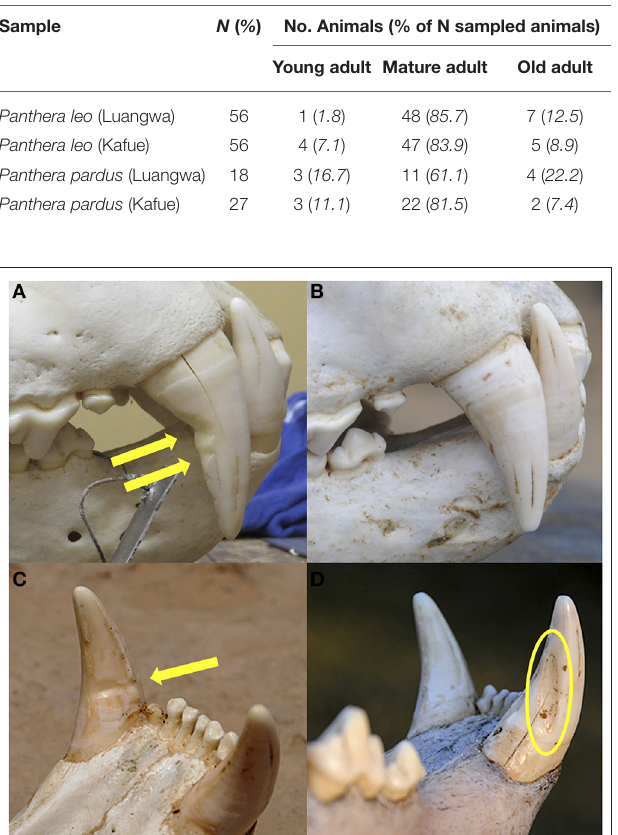
FIGURE 2 | Lion upper canine teeth of (A) a snared lion showing characteristic horizontal notches (arrows) resulting from biting and pulling on wire, and (B) a lion of similar age with no evidence of having been snared showing normal age-related tooth wear. Lion lower canine teeth showing (C) horizontal notch characteristic of snare damage, and (D) near-vertical groove (shown in oval) that is a result of normal age-related tooth wear from occlusion with the upper